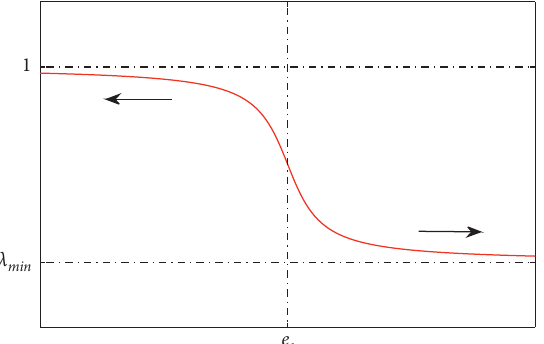
Figure 13: The adjustment function of the forgetting